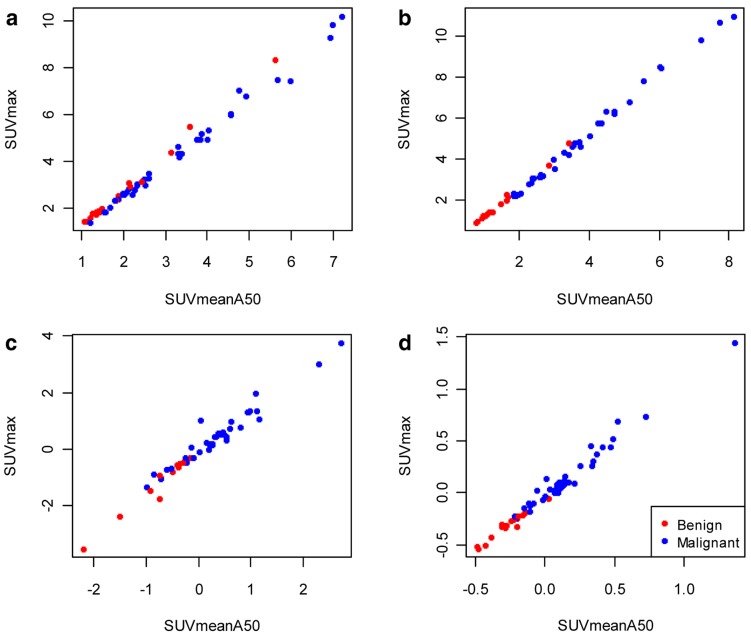
Comparison of SUVmax and SUVmeanA50.
a Early = 2 min p.i.; b Late = 30 min p.i.; c Difference = SUVlate – SUVearly; d Relative difference = (SUVlate – SUVearly)/SUVearly. At the early scan time point, SUVmax = 1.40*SUVmean –0.07(Benign) –0.27(Malignant); versus a reduction of −0.07 in the intercept at the late (30 min p.i.) assessment.